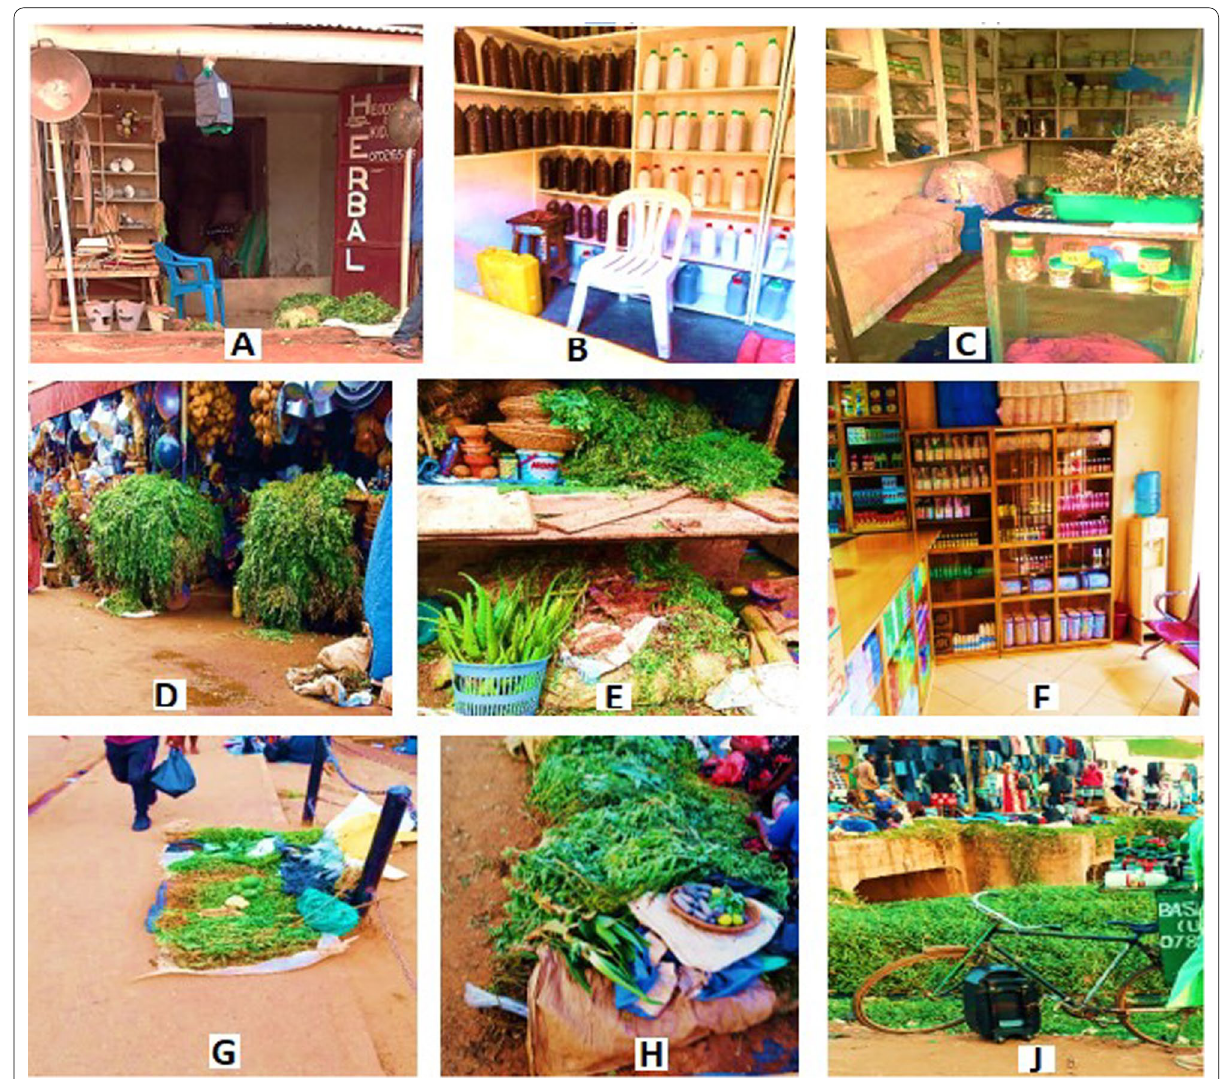
Fig. 5 Some traditional health care establishments in Kampala city, where herbal medicines are traded: formal HMSE ( A – C herbal shops; D , E market stalls; F pharmacy). Informa HMSE ( G , H roadside stalls; J mobile